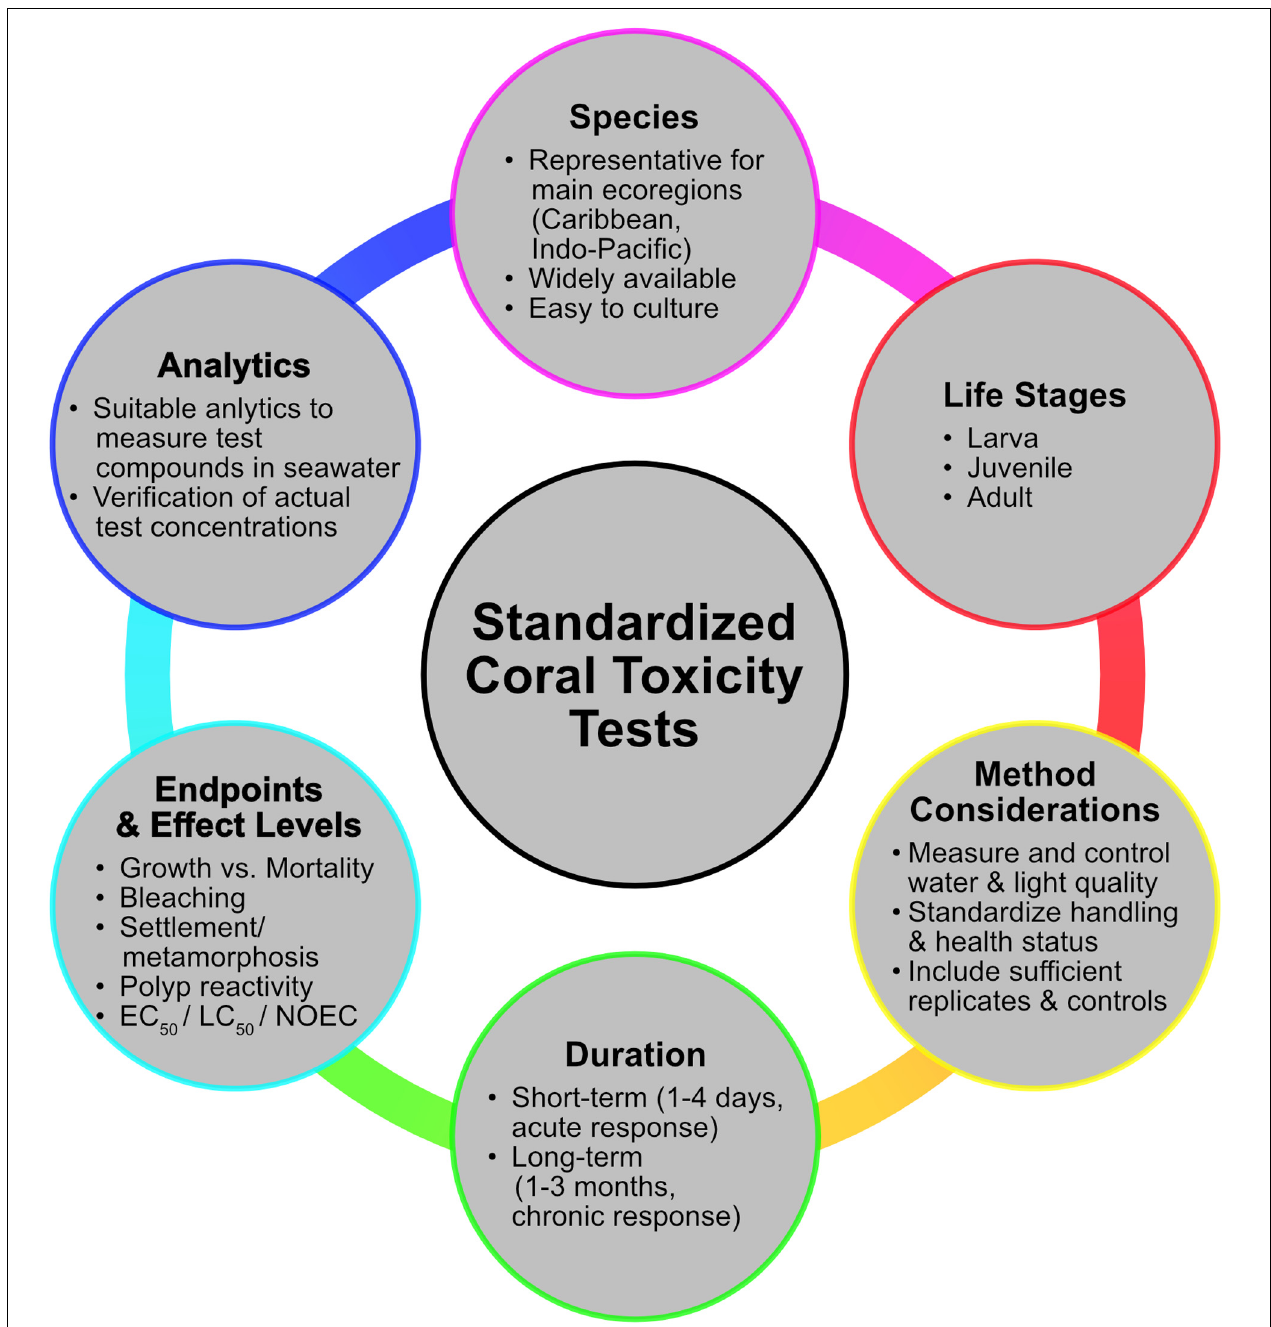
FIGURE 2 | The main aspects that need to be considered when planning standardized toxicity testes with scleractinian corals.